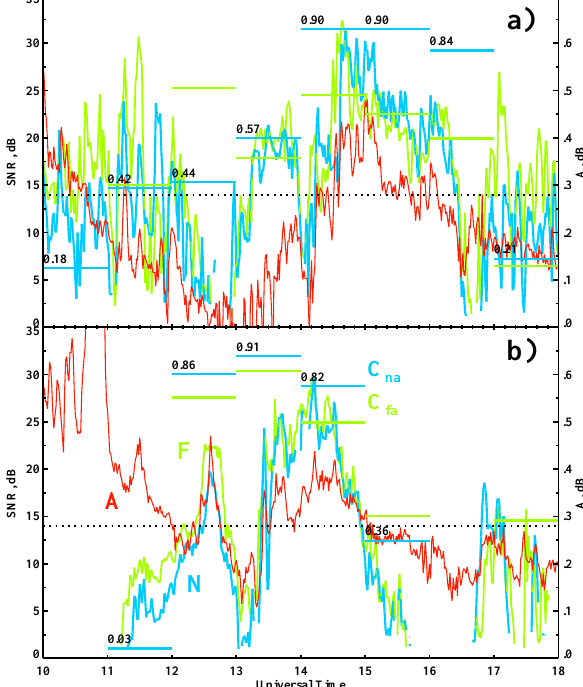
Fig. 2. Cosmic noise absorption (CNA) in IRIS beam 41 at 1-min resolution for (a) 12 and (b) 14 February 2000, 10:00–18:00 UT (red line). Backscatter power (SNR) of the STARE Norway (Fin- land) echoes in the closest cell (see Fig. 1) is shown by the blue (green) line. The correlation coefficients between CNA and SNR of the STARE Norway and Finland echoes ( C na and C fa ) for each 1-h period are shown by the blue (green) horizontal lines, respec- tively, with the digits above and height from the bottom of each panel showing the amount of correlation. The 0.4 levels are shown by the dotted horizontal